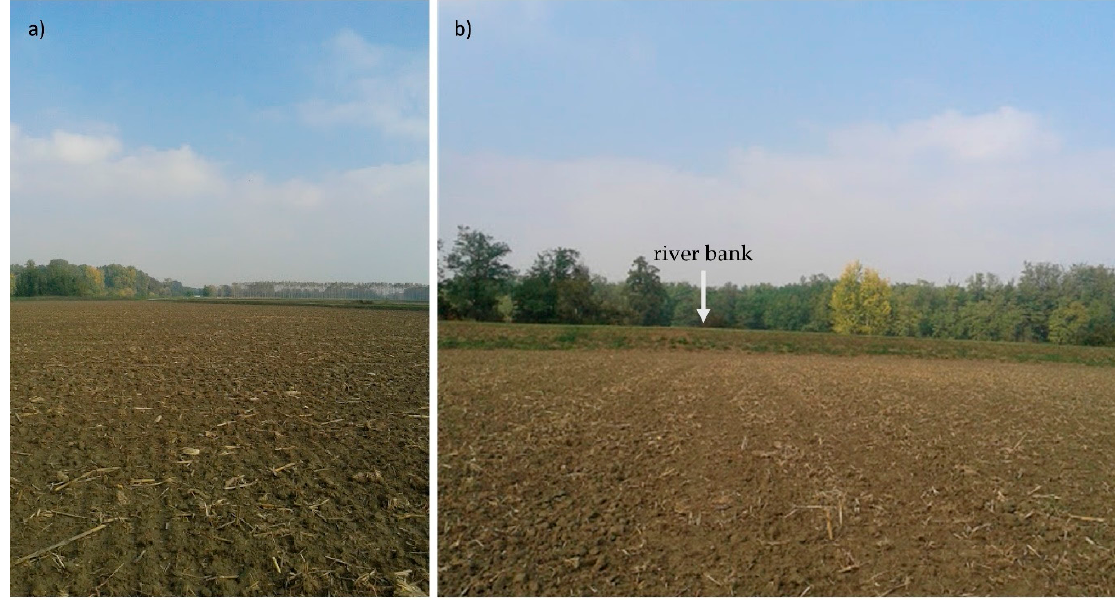
Figure 2. Picture of the alluvial plain of the southern block, close to the Po River Valley ( a ). In figure ( b ) is shown the river bank, that has a height of about 2 m. A belt of trees and natural vegetation, about 150 m wide, is located between the Po River and its bank.